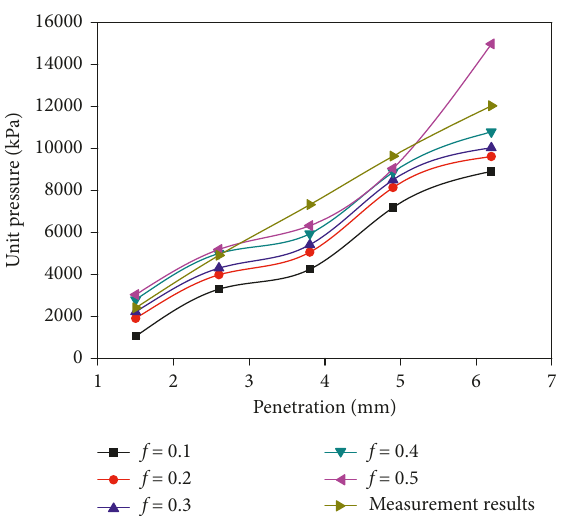
Figure 3: Unit pressure and penetration under different friction coefficients.